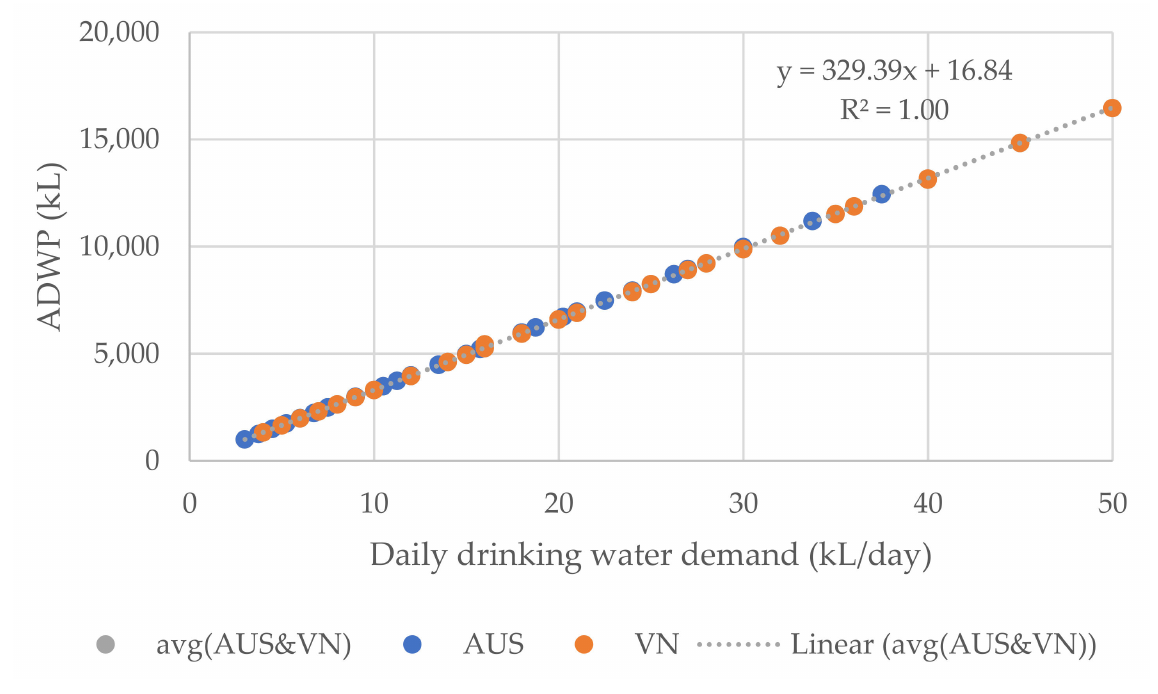
Figure 9. Correlation between daily drinking water demand and ADWP for the Australian and Vietnamese RWH systems.